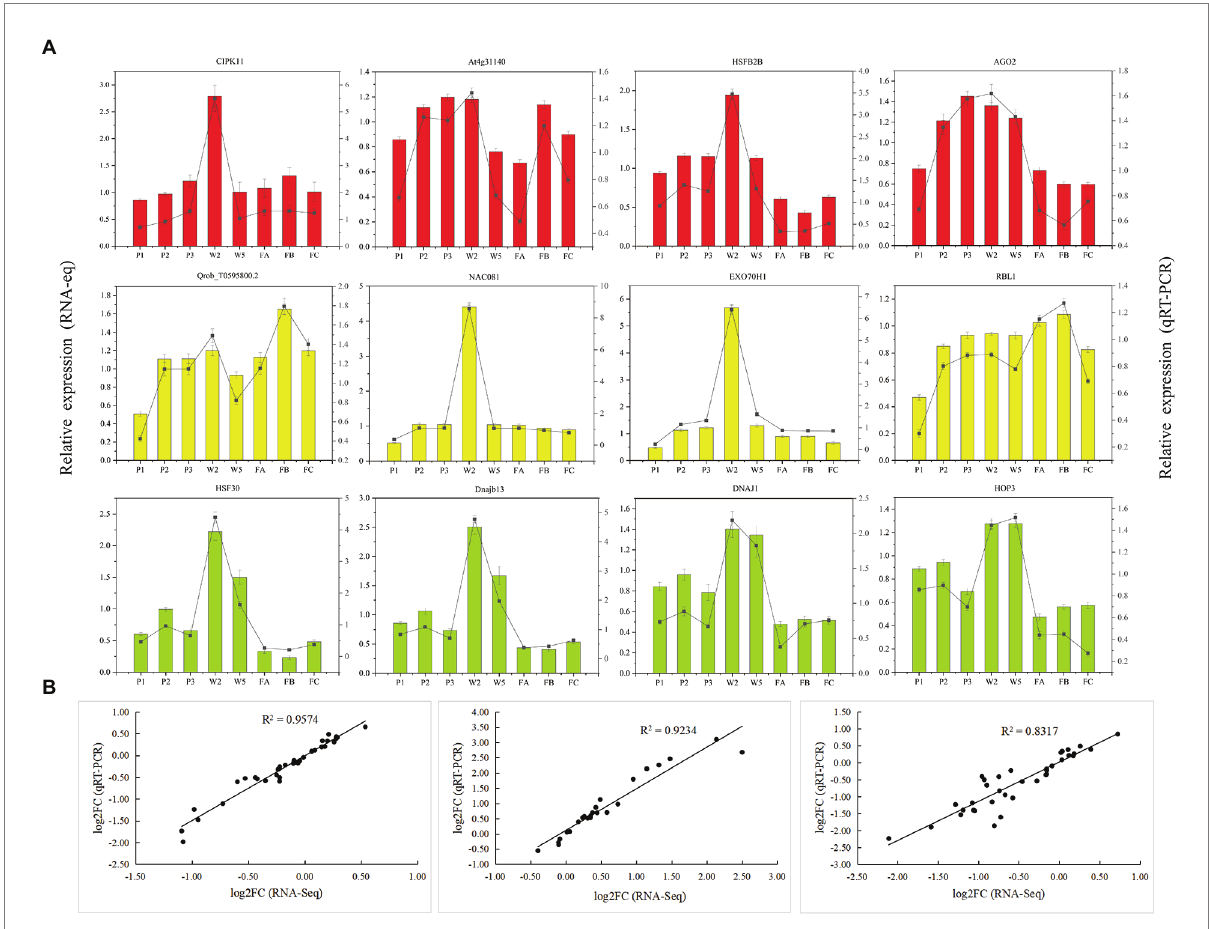
FIGURE 9 Validation of the selected genes in Quercus mongolica from RNA-Seq by qRT-PCR. (A) RNA-Seq and qRT-PCR results of hub genes from red, yellow and green-yellow modules. (B) Comparison of the log2 of gene expression ratios between RNA-Seq data and qRT-PCR results in P, W, and F treatments,